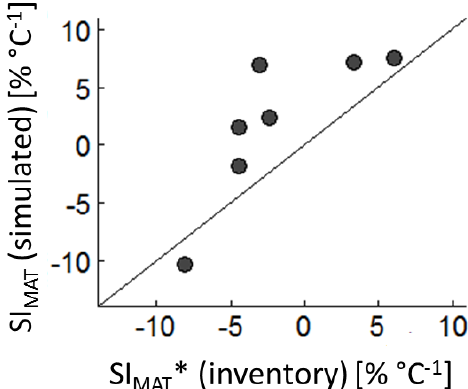
Figure 3. SI MAT values of seven different forest types derived from the analysis of the German forest inventory vs. SI MAT values de- rived from corresponding forest types of the forest factory. Only those SI MAT values of the field data are analysed which showed p values smaller than